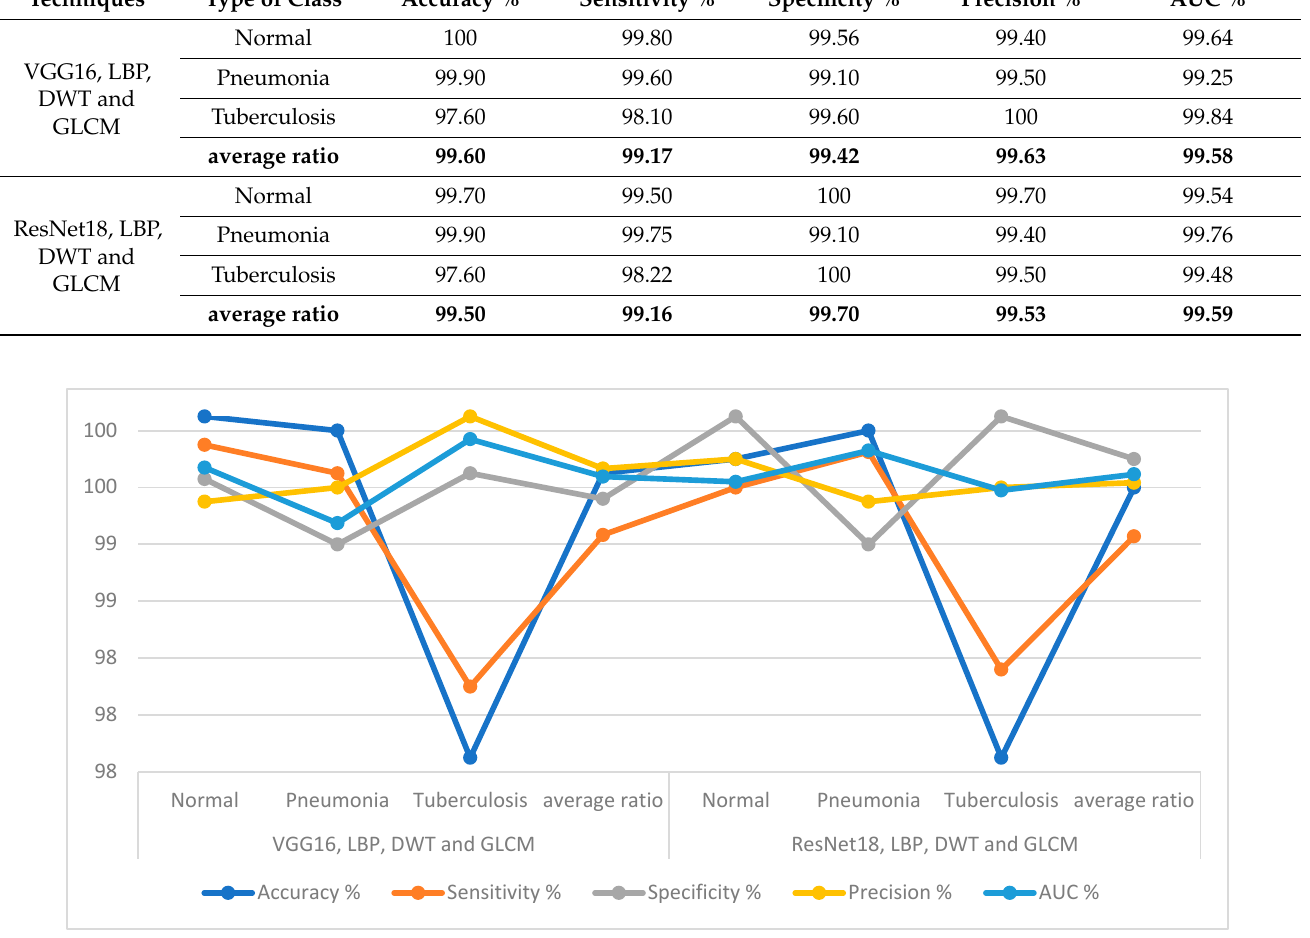
Table 5. ANN performance based on the fusion of CNN features with hand-crafted features.